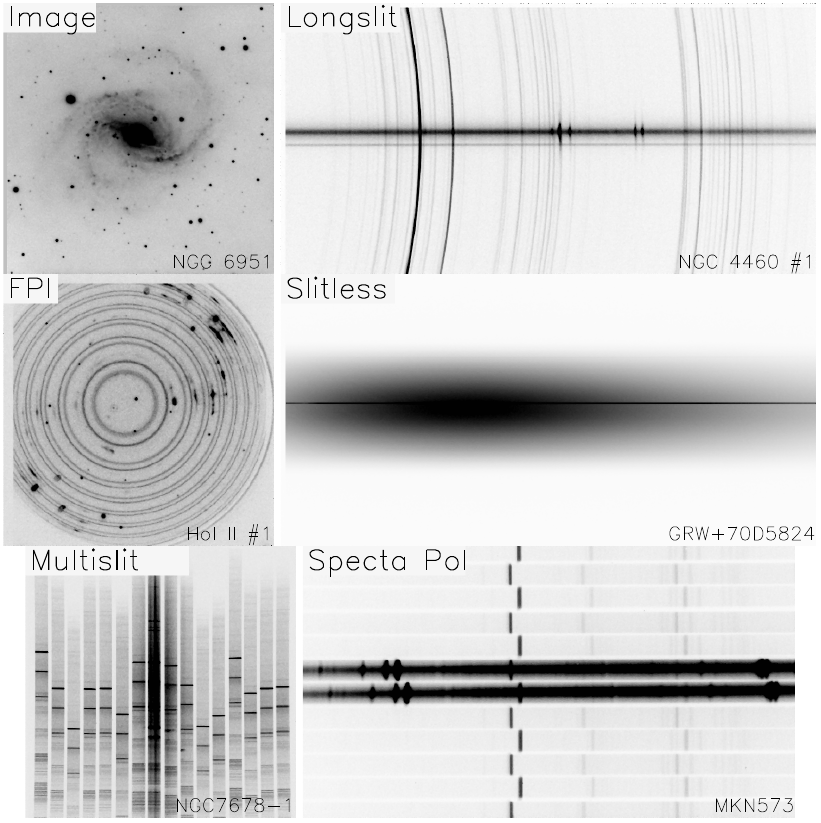
Fig. 2. Examples of the data frames for different SCORPIO